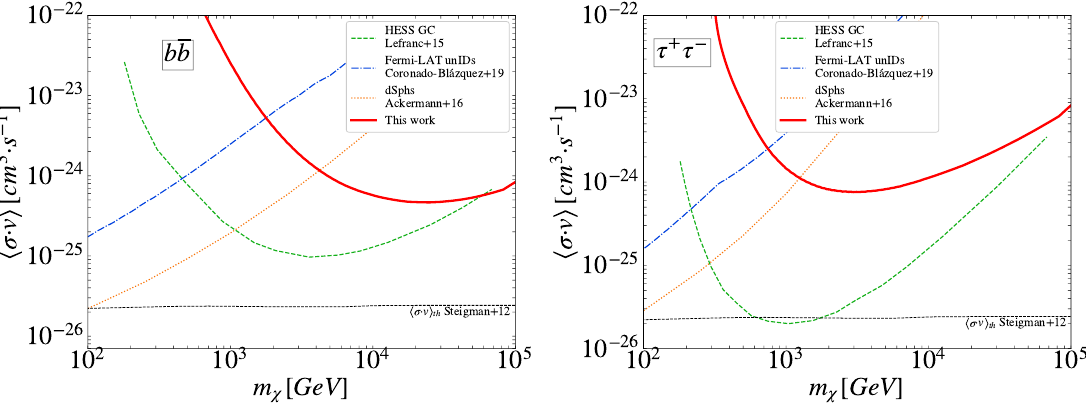
Figure 4. 95% upper limits on the DM annihilation cross section as derived from HAWC unIDs and predictions from N-body cosmological simulations. Indeed, these constraints use 2HWC J1040 + 308 alone, i.e., the only HAWC unID located at | b | ≥ 10 ◦ and surviving our selection criteria in Section 2.2. Left (right) panel shows the 95% C.L. upper limits for the b ¯ b ( τ + τ − ) annihilation channel. For comparison, we also show as a blue, dot-dashed line the DM constraints obtained from Fermi-LAT unIDs using the same methodology [47]. Limits from the observation of the Galactic center region by H.E.S.S., i.e., the best DM constraints achieved from IACT observations at present, are included in both panels as well as a green, dashed line [65]. Finally, a dotted, orange line shows the constraints from Fermi -LAT observations of dSphs [59]. Please note that we did not include in this Figure the results in [35], as a one-to-one comparison would be misleading given the fact that the methodology and underlying assumptions in both works are significantly different; see discussion in Section 3 for